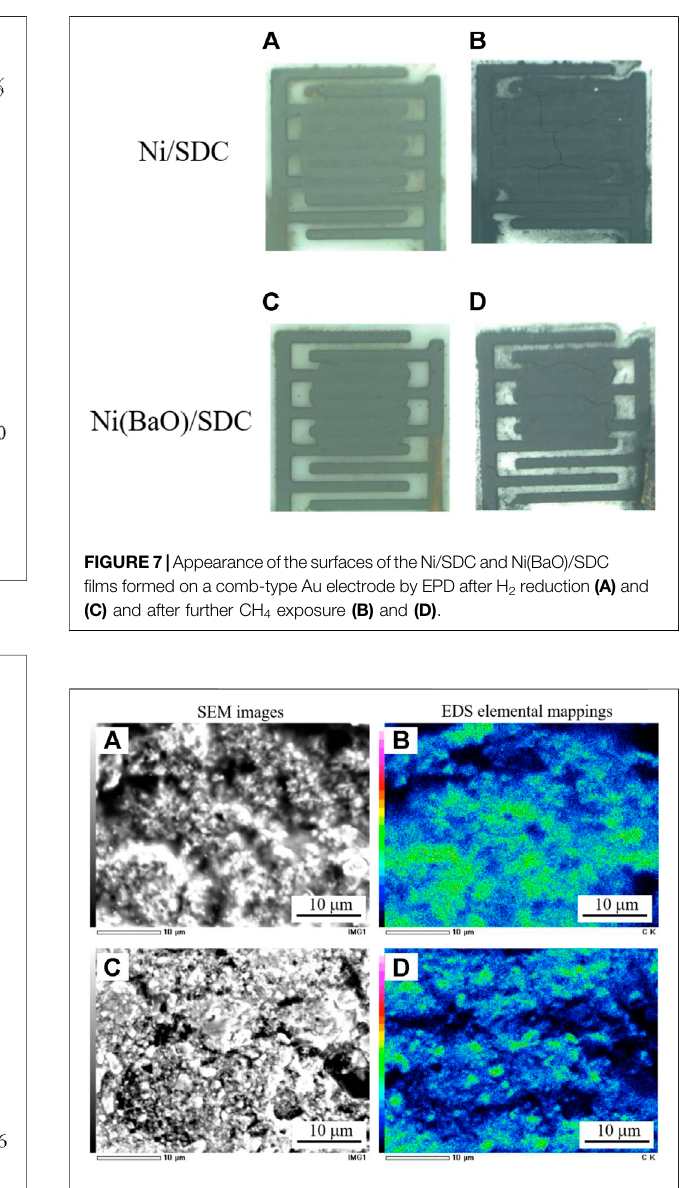
FIGURE 8 | Cross-sectional SEM and EDS images of the anode disks exposed with methane at 700 ° C for 1 h: SEM images (A) Ni/SDC and (C) Ni(BaO)/SDC, and carbon elemental mappings (B) Ni/SDC and (D) Ni(BaO)/SDC.